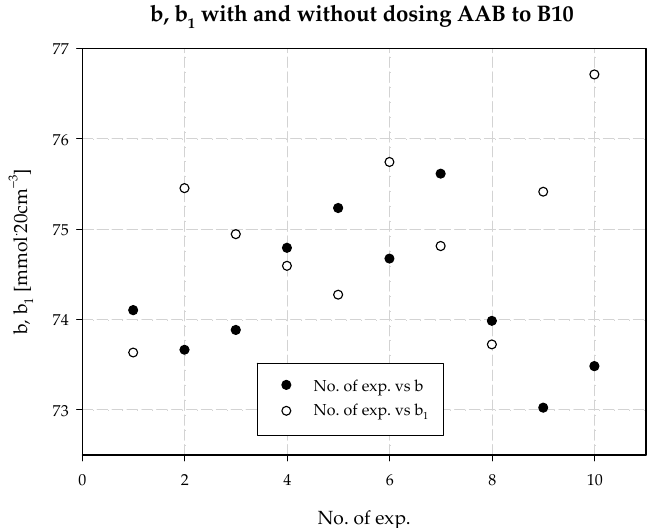
Figure 12. b with and without dosing of AAB to B10.